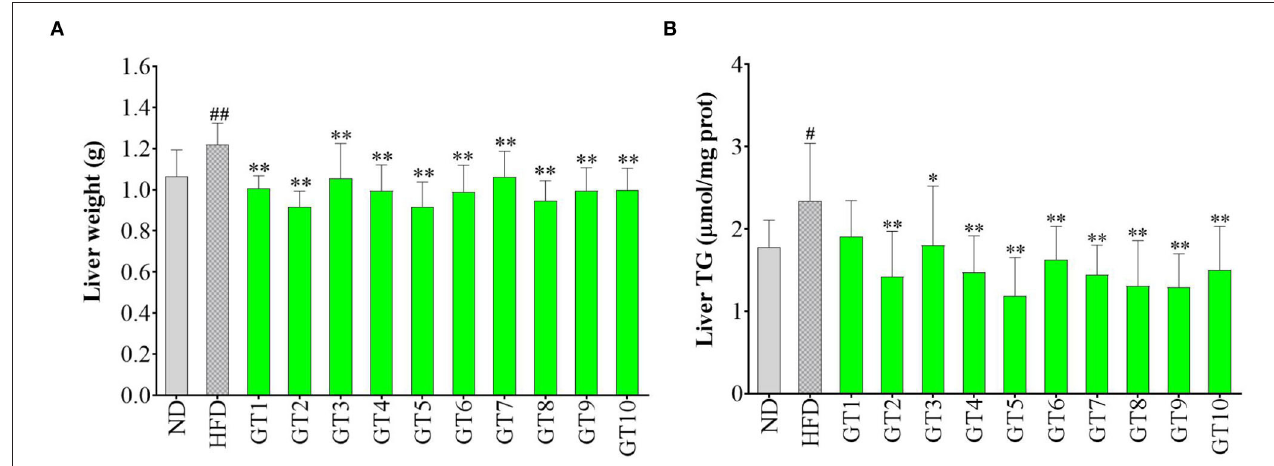
FIGURE 4 | Effects of green teas on weight and TG content of liver. (A) Liver weight and (B) Liver triglyceride (TG) content. # p < 0.05, ## p < 0.01, the model group vs. the control group; * p < 0.05, ** p < 0.01, the green tea groups vs. the model group. ND, normal diet; HFD, high-fat diet; GT1, Dianqing Tea; GT2, Jieyang